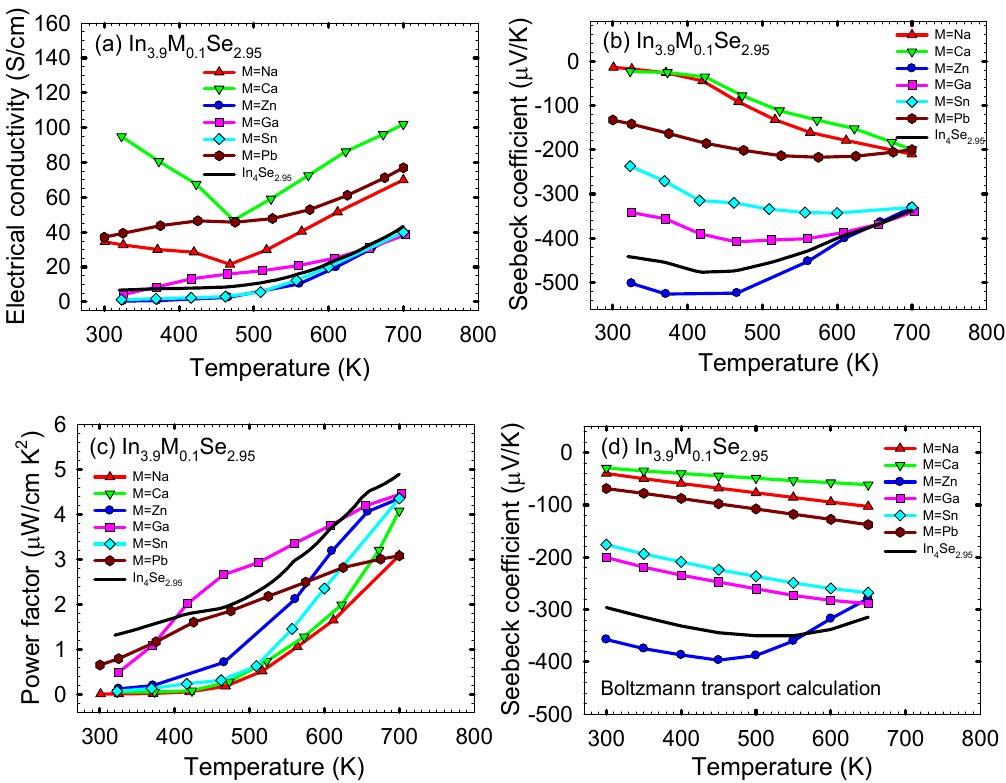
Figure 11. Temperature dependence of ( a ) electrical conductivity, ( b ) Seebeck coefficient, ( c ) power factor, and ( d ) calculated Seebeck coefficient by Boltzmann transport equation of polycrystalline samples of In 3.9 M 0.1 Se 2.95 (M = Na, Ca, Zn, Ga, Sn, Pb) and In 4 Se 2.95 . Reproduced with permission from AIP Publishing LLC, 2011 [27]. Table 3. Room temperature carrier concentrations and Hall mobilities of the